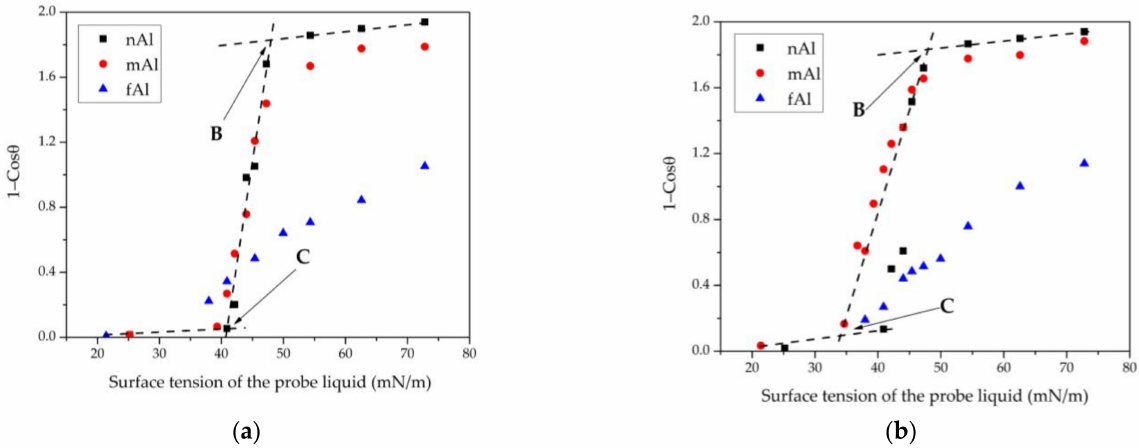
Figure 7. Zisman plots after surface treatment with ( a ) OCTEO and ( b ) POTS; B—the Cassie- Wenzel threshold; C—extrapolated complete wetting point for textured surfaces (the blue dot line is the tangent to the B-C curve segment and the black dot line is the tangent to the A-B and C-D curve